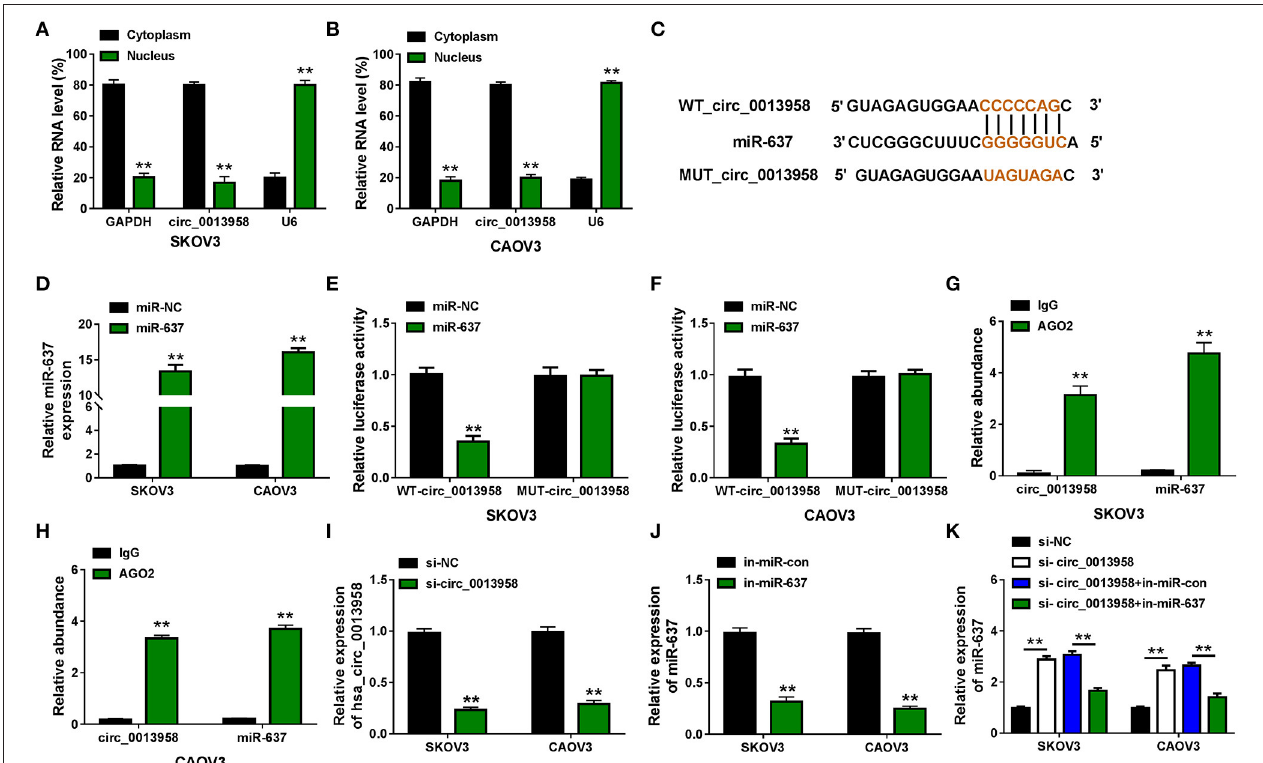
FIGURE 2 | Circ_0013958 acts as a sponge for miR-637 in OC cells. (A,B) Nuclear-cytoplasmic fractionation assay for the subcellular location of circ_0013958 in SKOV3 and CAOV3 cells. (C) Binding sites between circ_0013958 and miR-637 were predicted by the CircInteractome database. (D) QRT-PCR assay for the expression of miR-637 in SKOV3 and CAOV3 cells transfected with miR-NC or miR-637. (E,F) Dual-luciferase reporter assay for the luciferase activity of SKOV3 and CAOV3 cells cotransfected with WT-circ_0013958 or MUT-circ_0013958 and miR-NC or miR-637. (G,H) RIP assay for the enrichment of circ_0013958 and miR-637 in SKOV3 and CAOV3 incubated with IgG or AGO2 antibody. (I) QRT-PCR analysis for the expression of circ_0013958 in SKOV3 and CAOV3 cells transfected with si-NC or si-circ_0013958. (J) QRT-PCR analysis for the expression of miR-637 in SKOV3 and CAOV3 cells transfected with in-miR-con or in-miR-637. (K)